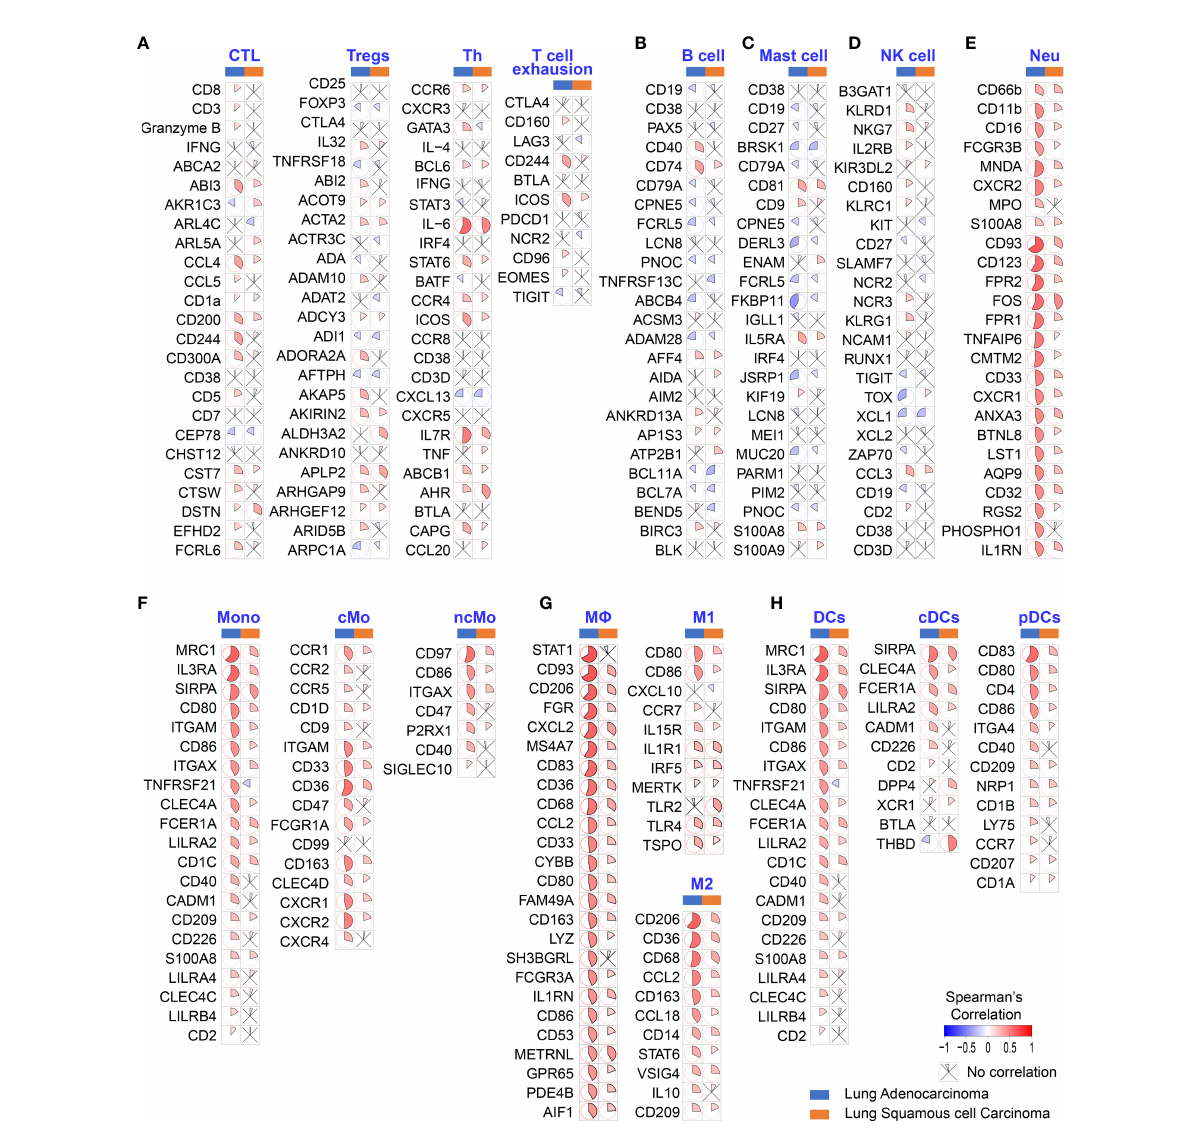
FIGURE 2 Correlation between HB-EGF expression level and immune gene markers in the lung cancer TGCA database. The color and sector represent Spearman ’ s correlation between HB-EGF and immune gene markers: (A) T lymphocyte markers (CTC: cytotoxic T cells, Treg: regulatory T cells, and Th: T helper cells); (B) B lymphocyte markers; (C) Mast cell markers; (D) Natural killer (NK) cell markers; (E) Neutrophil markers (Neu); (F) Monocyte markers; (G) Macrophage markers (M1 and M2 subtypes); and (H) Dendritic cell markers (DC, dendritic cell; cDCs, conventional dendritic cells; and pDCs, plasmacytoid dendritic cells). (LUAD, lung adenocarcinoma; LUSC, lung squamous cell